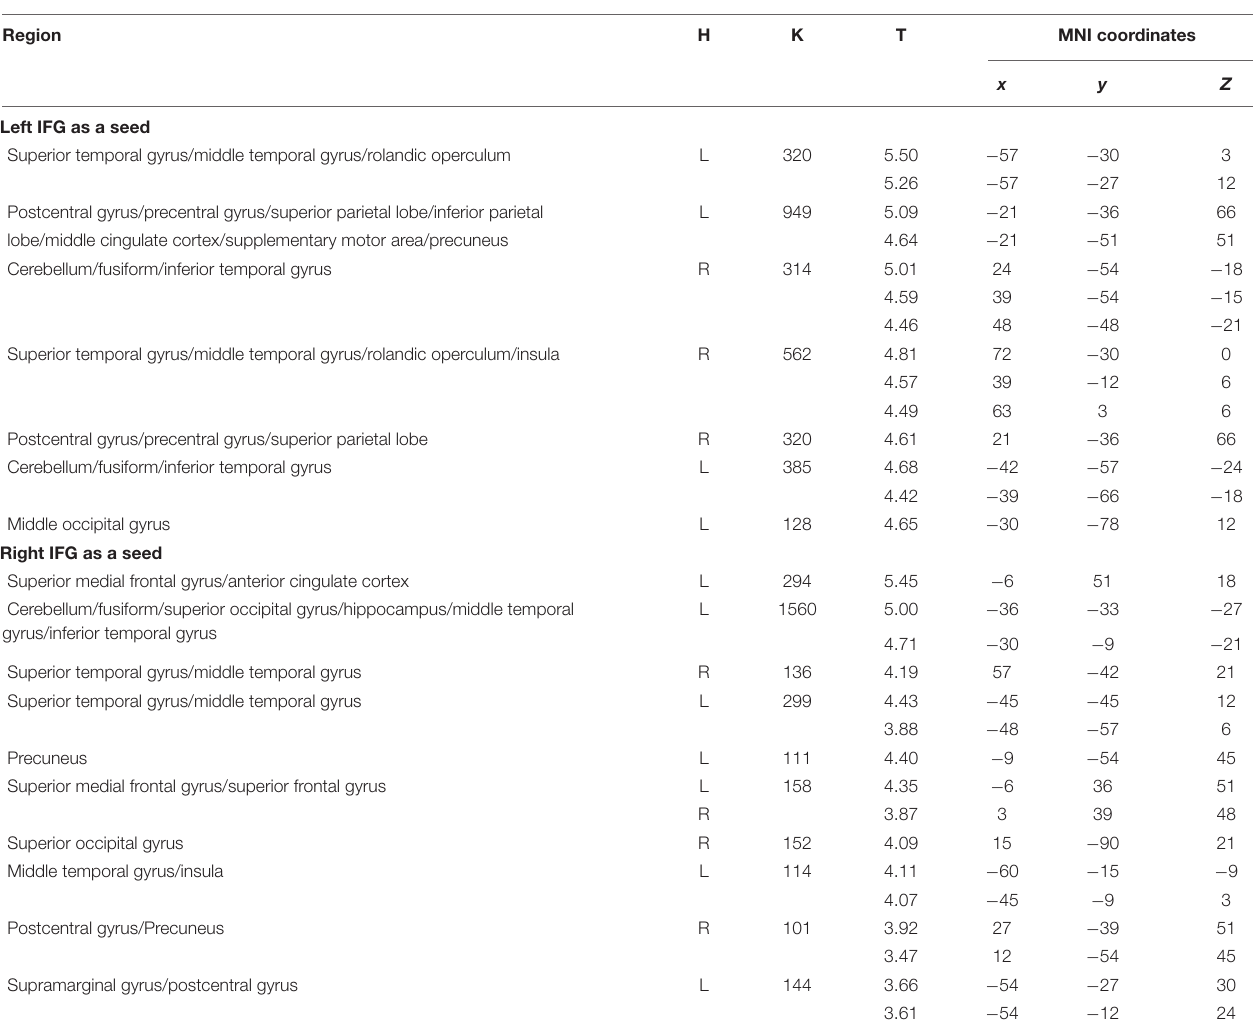
TABLE 4 | Functional connectivity